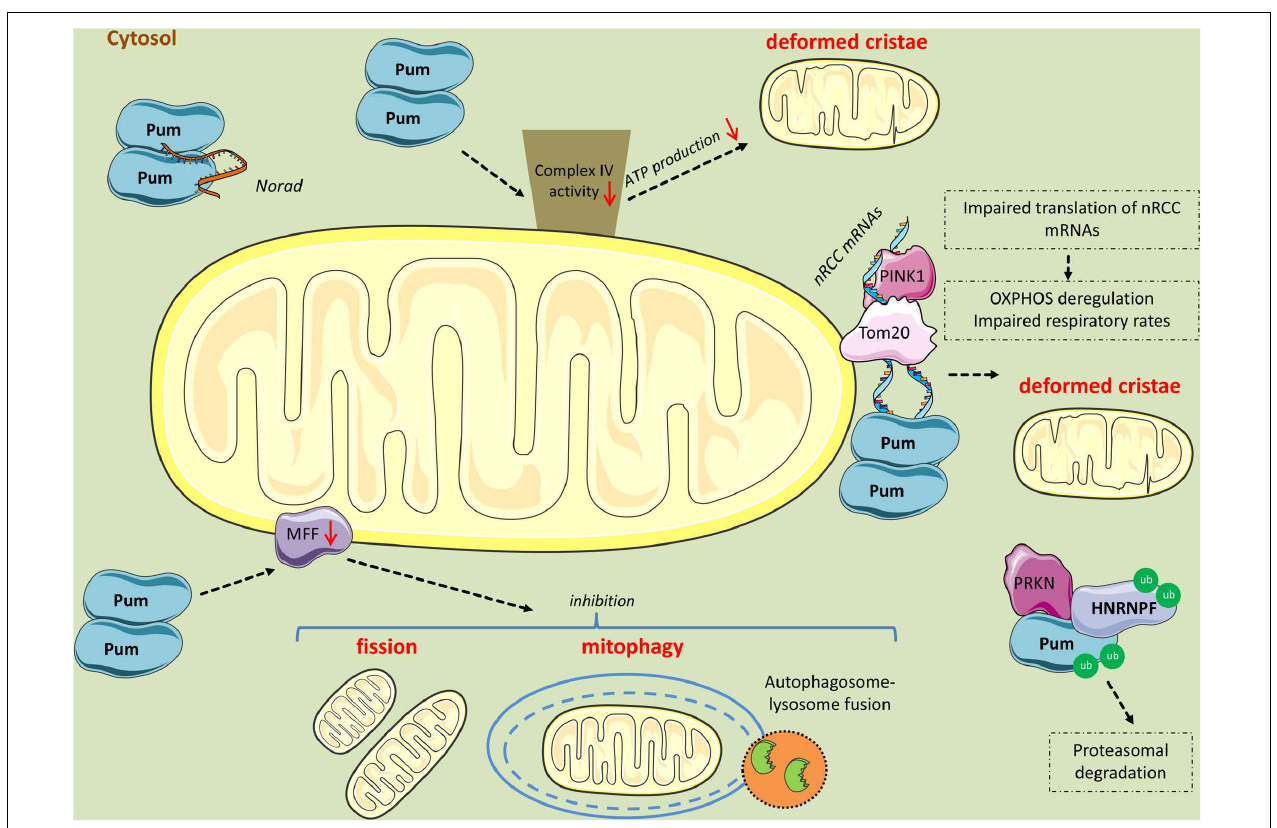
FIGURE 4 | Mitochondrial perturbations induced by PUM2. PUM2 reduces cytochrome c oxidase complex (Complex IV) activity, leading to impaired respiration and deformed cristae. Interestingly, the long non-coding RNA NORAD inhibits PUM2 function by sequestering PUM2 from binding to mitochondrial mRNA targets. Further, PINK1 in association with Tom20 promote the expression of nuclear-encoding mitochondrial ( nRCC ) mRNAs in the outer mitochondrial membrane by competing with PUM and other translation repressors. PINK1 competes with PUM for mRNA-binding, while PRKN mono-ubiquitinates PUM and HNRNPF lowering their affinity for nRCC mRNAs and possibly leading to their proteasomal degradation. However, when PUM is in excess, it binds to the nRCC mRNAs and represses their translation. Finally, PUM2 binds to MFF mRNA and represses its translation, leading to reduced fission and